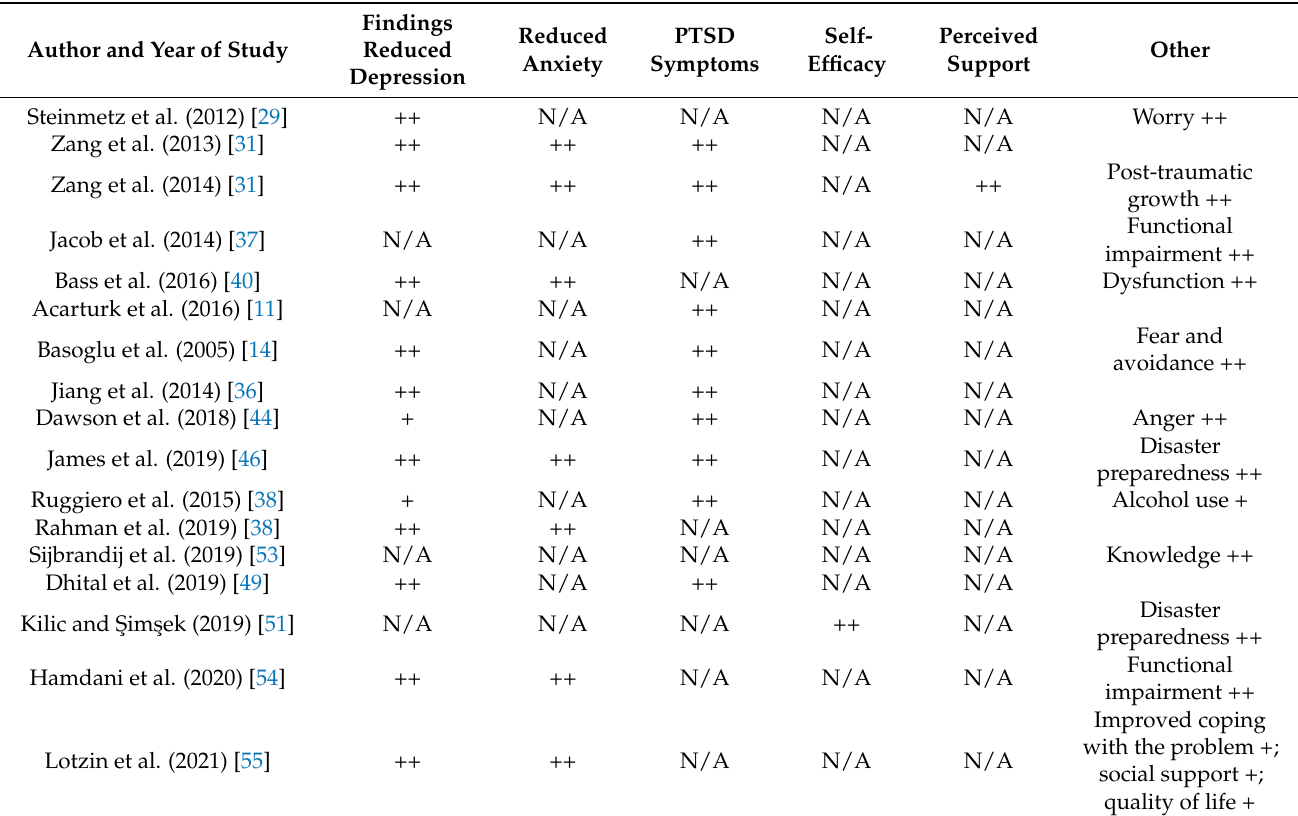
Table 4. Summary of Findings of